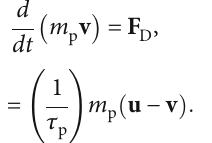
is 3 MPa, and (c) σ n0